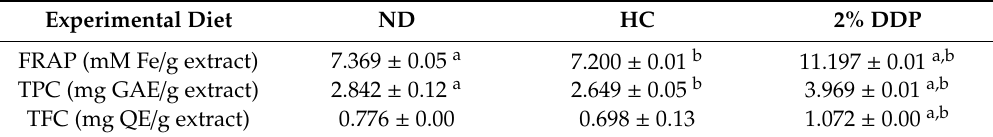
Table 3. Antioxidant profile in treatment diets.